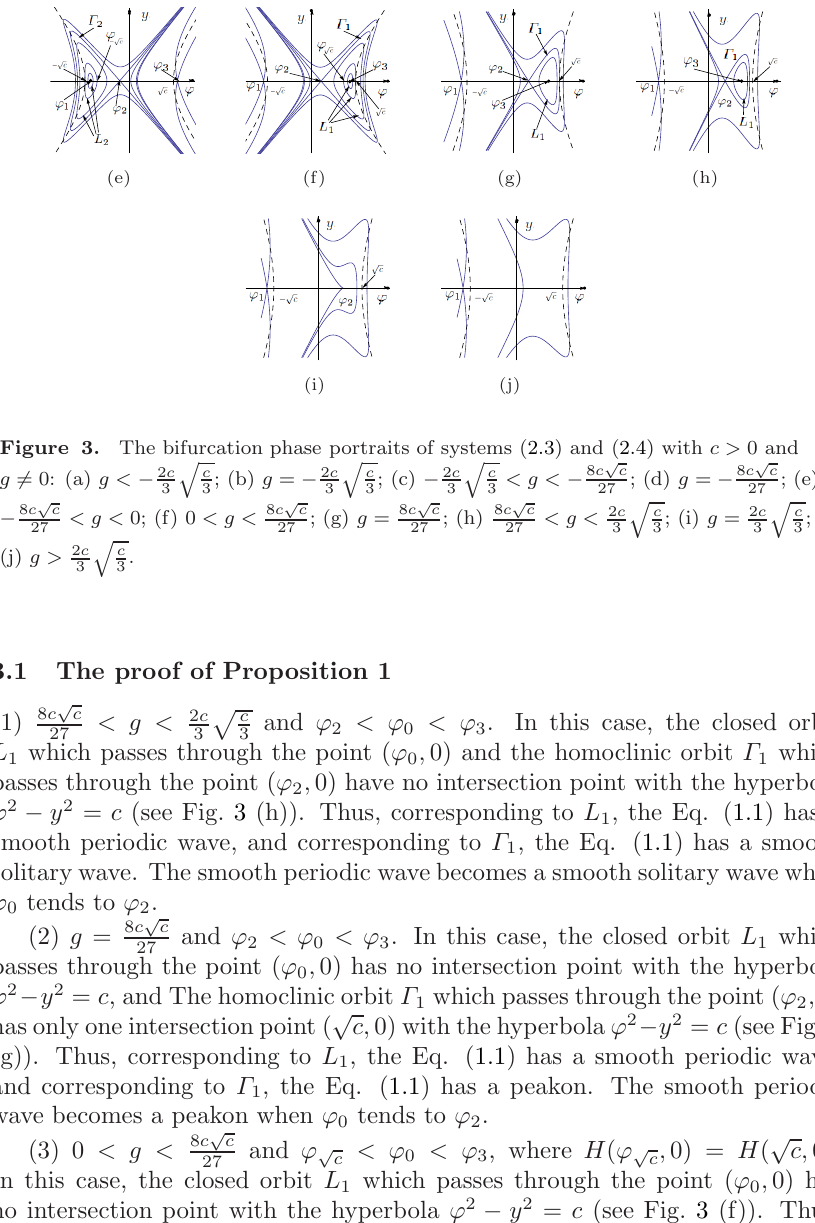
√ c 8 c 27 ; (e) c 2 c 3 q 3